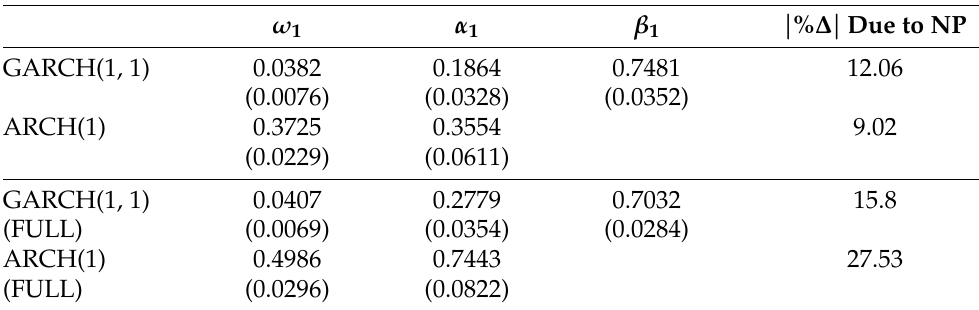
Table 2. The table reports coefficients of the ARCH ( 1 ) and GARCH ( 1,1 ) models with standard errors in parentheses. The results from the top panel are based on estimates obtained from the training data set, t = 1, . . . ,925, whereas the results from the bottom panel are based on estimates obtained from the entire data set t = 1, . . . ,1305. ω 1 is the intercept of the conditional variance, α 1 is the coefficient of the ARCH term, and β 1 is the coefficient of the GARCH term. The last column contains the estimates of the mean absolute percentage change of the conditional variance due to the nonparametric component, calculated by Equation